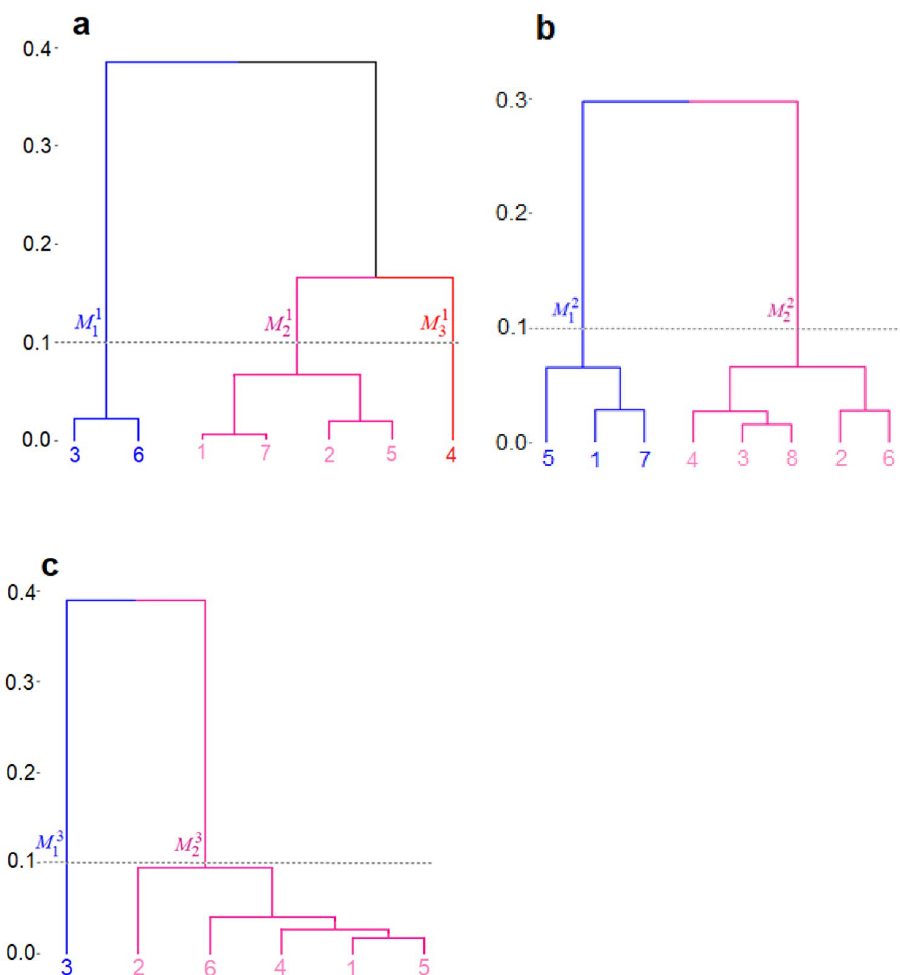
Figure 4. Metaclustering of the clusters was performed using the clinical covariates of the samples in each cluster. The results are shown using dendrograms for age groups ( a ) 1, ( b ) 2, and ( c ) 3. The y-axis shows the distance between metaclusters. The leaves of a dendrogram denote the Id-s of the clusters identified by the previous clustering step. The metaclusters are obtained by a flat cut of each dendrogram at the common height of 0.1, and the labels and subtrees representing them are shown in different colors (blue, pink, and